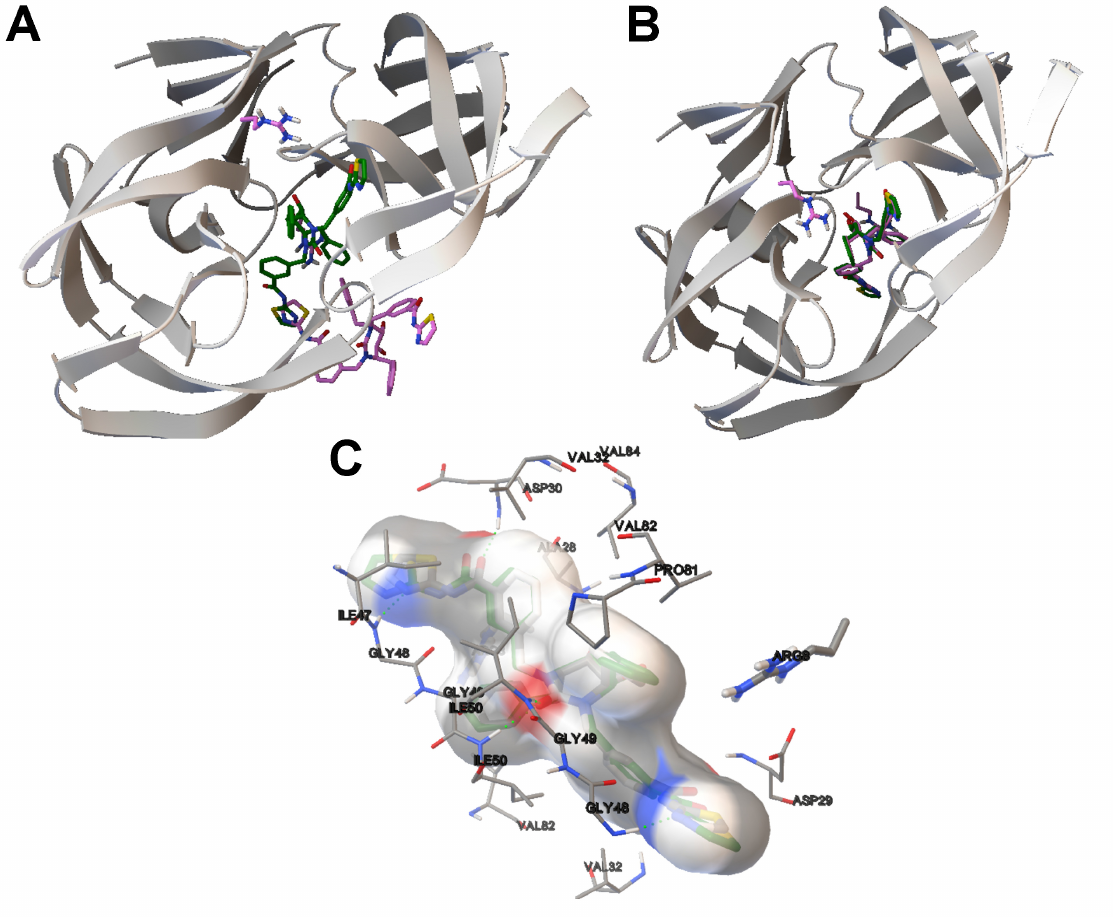
Figure 7. ( A , B ) The ligand conformations for instance 1BV9 that have been generated by the LGA and SMPSO algorithms. The computed ligand conformations are in purple and the reference ligand in green. ( A , B ) show the HIV-protease in 3D, colored in grey; ( C ) The molecular interactions between the ligand conformation returned by the SMPSO algorithm and the receptor. The H-bonds are represented by green spheres. The amino acids closest to the computed ligand have been